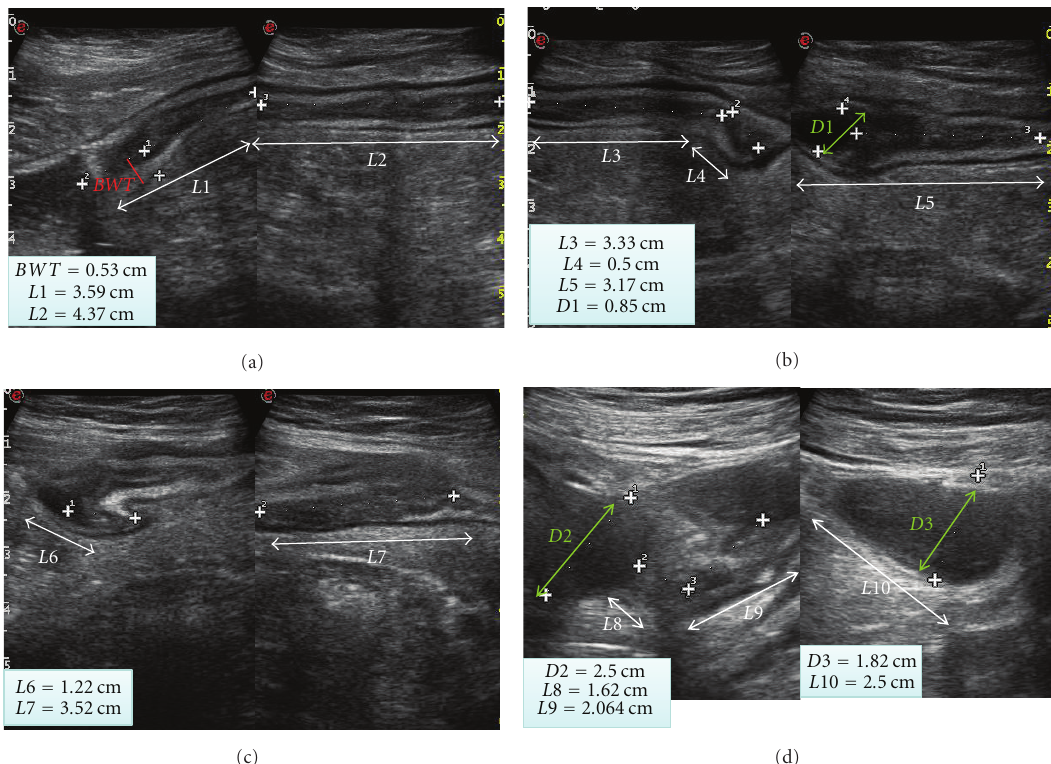
Figure 1: Small intestine contrast ultrasonography in a 20-year-old female with Crohn’s disease. In each panel ((a)–(d)) white arrows indicate disease extent of the terminal ileum. The cumulative extent of the sonographic Crohn’s disease lesion was 26 cm. In (a), on the left side, red arrow indicates bowel wall thickness (5.3mm) of the terminal ileum and in (b) (on the left side) and (d) green (both right and left sides) arrows indicate lumen diameter (raging from 8 to 22 mm) at level of the terminal